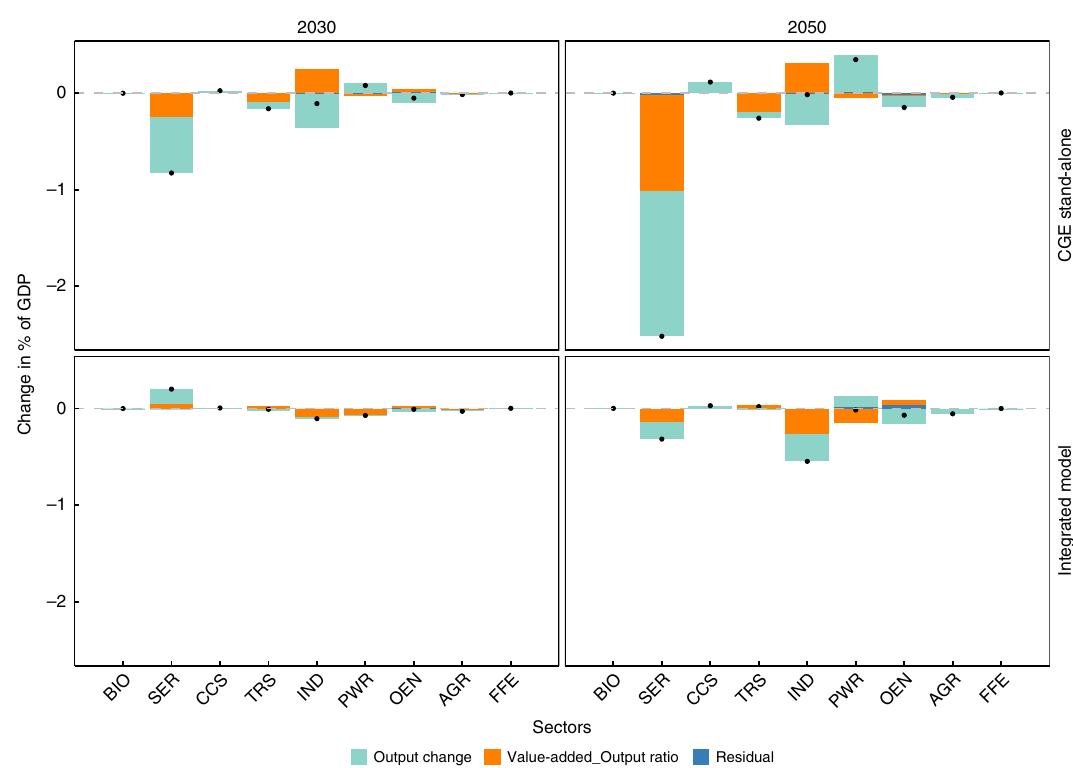
Fig. 5 Decomposition analysis of GDP changes across sectors. Value-added changes relative to baseline scenarios are expressed as percentages of GDP. Legend entries Output change, Value-added_output ratio, and Residual refer to output changes, value-added productivity changes, and residuals, respectively. The top and bottom panels show CGE stand-alone and integrated model results, respectively. Sectors are BIO Bioenergy industry, SER